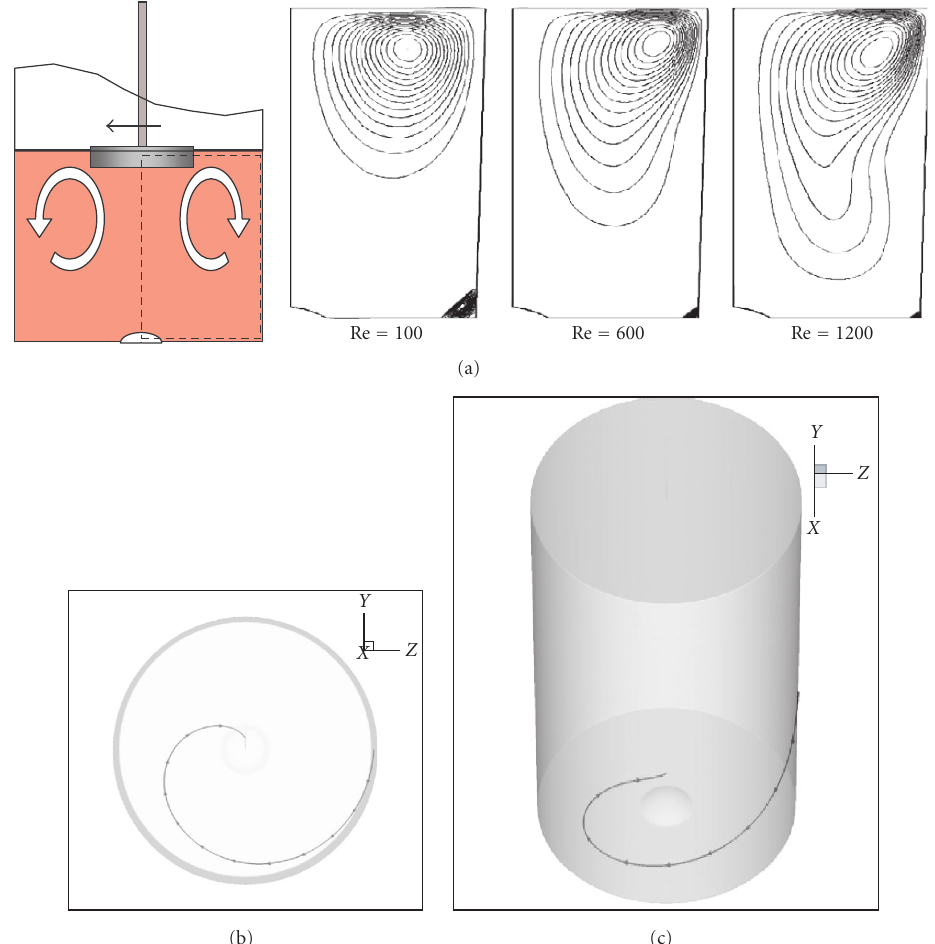
Figure 3: Computational modeling of fluid flow patterns in the RDB. (a) Cross sectional streamlines emanating from fluid surface in the vicinity of the fluid surface, demonstrating a laminar flow vortex pattern. (b) Simulated trajectory of a single semibuoyant particle (an idealized cell aggregate) moving passively in response to flow in the meridional direction. (c) Three-dimensional simulation of the same particle from (b) after having been seeded near the fluid surface, and coming to rest passively near the RDB vessel